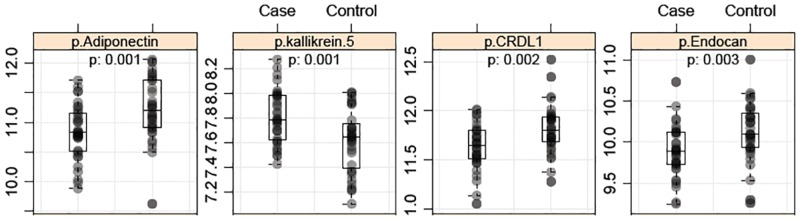
Scatterplot of prognostic protein biomarkers.Circulating levels of top-ranked prognostic biomarkers in IGT subjects (case, left) compared to healthy controls (right).